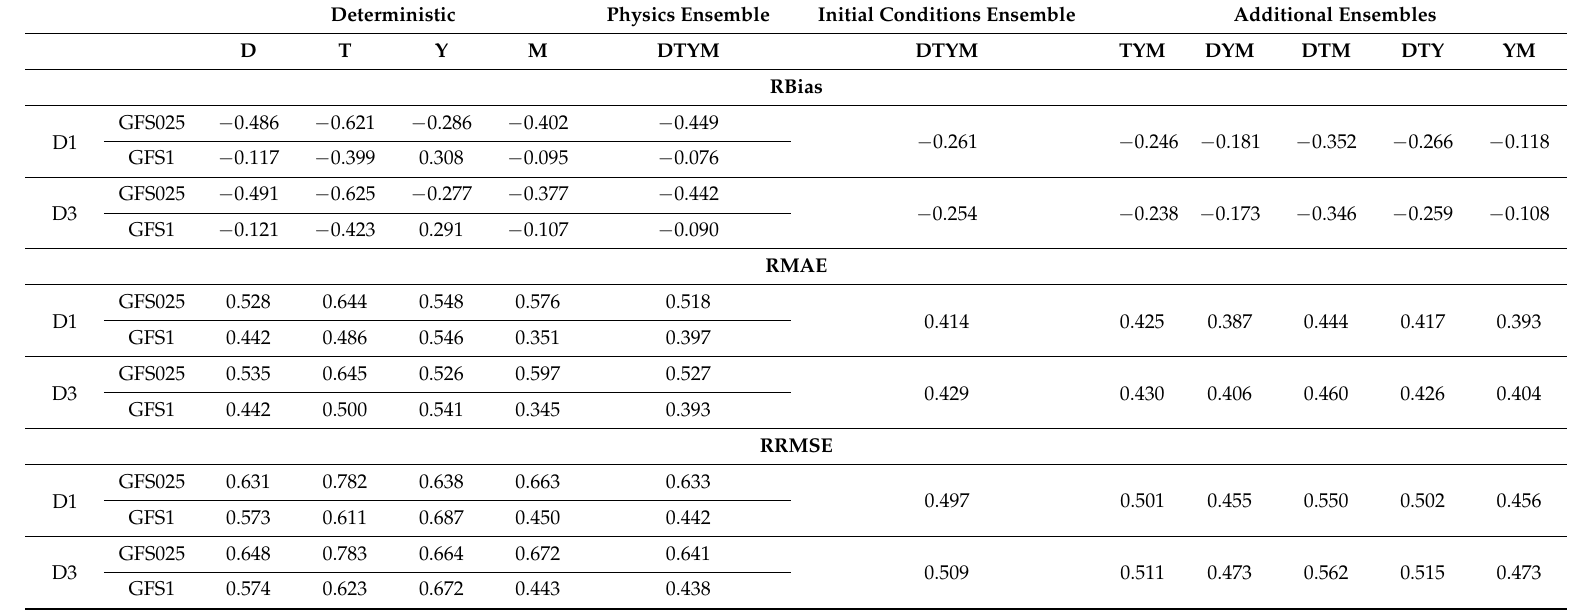
Table 4. Validation for accumulated precipitation, including Relative Bias, Relative Mean Absolute Error and Relative Root Mean Square Error. All 32 model configurations are shown for domain resolution, initial conditions resolution, microphysics parameterization, and ensembles chosen. The best three performers for each index are